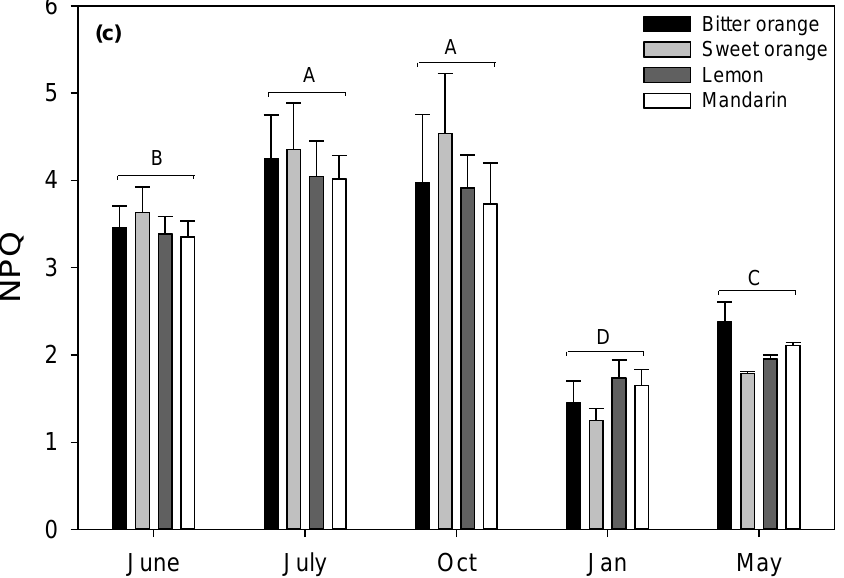
Figure 1. Seasonal variation of ( a ) potential efficiency of PSII photochemistry (F v /F m ), ( b ) actual photon yield of PSII photochemistry ( Φ PSII ), and ( c ) non-photochemical quenching (NPQ) in Citrus spp. leaves. Data are means ± standard error ( n = 5). A two-way ANOVA was applied; the significance levels ( p ) for plant species and month factors and their interactions are shown in Table 3.